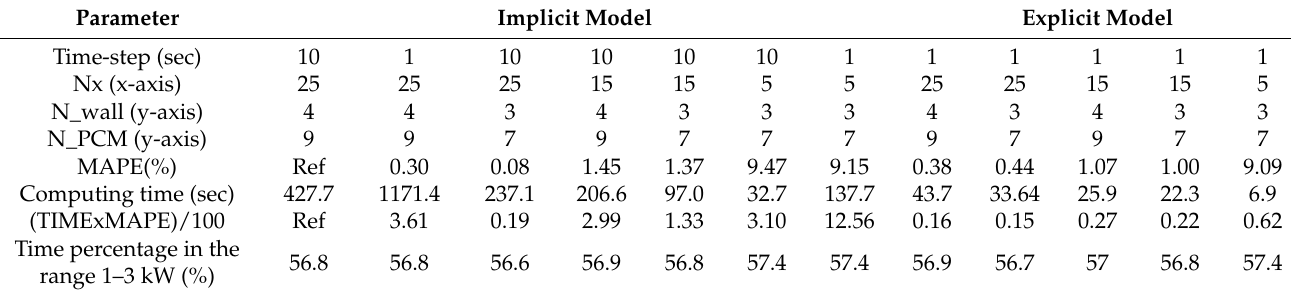
Table 4. Results for the studied model parameters of implicit and explicit